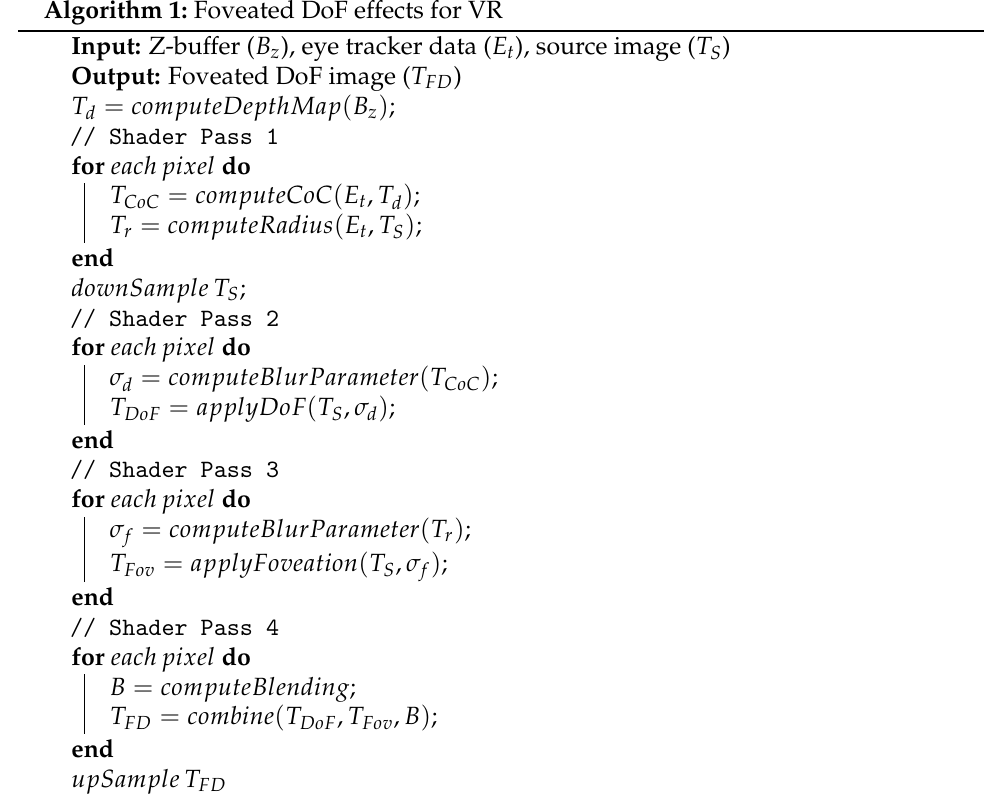
Algorithm 1: Foveated DoF effects for